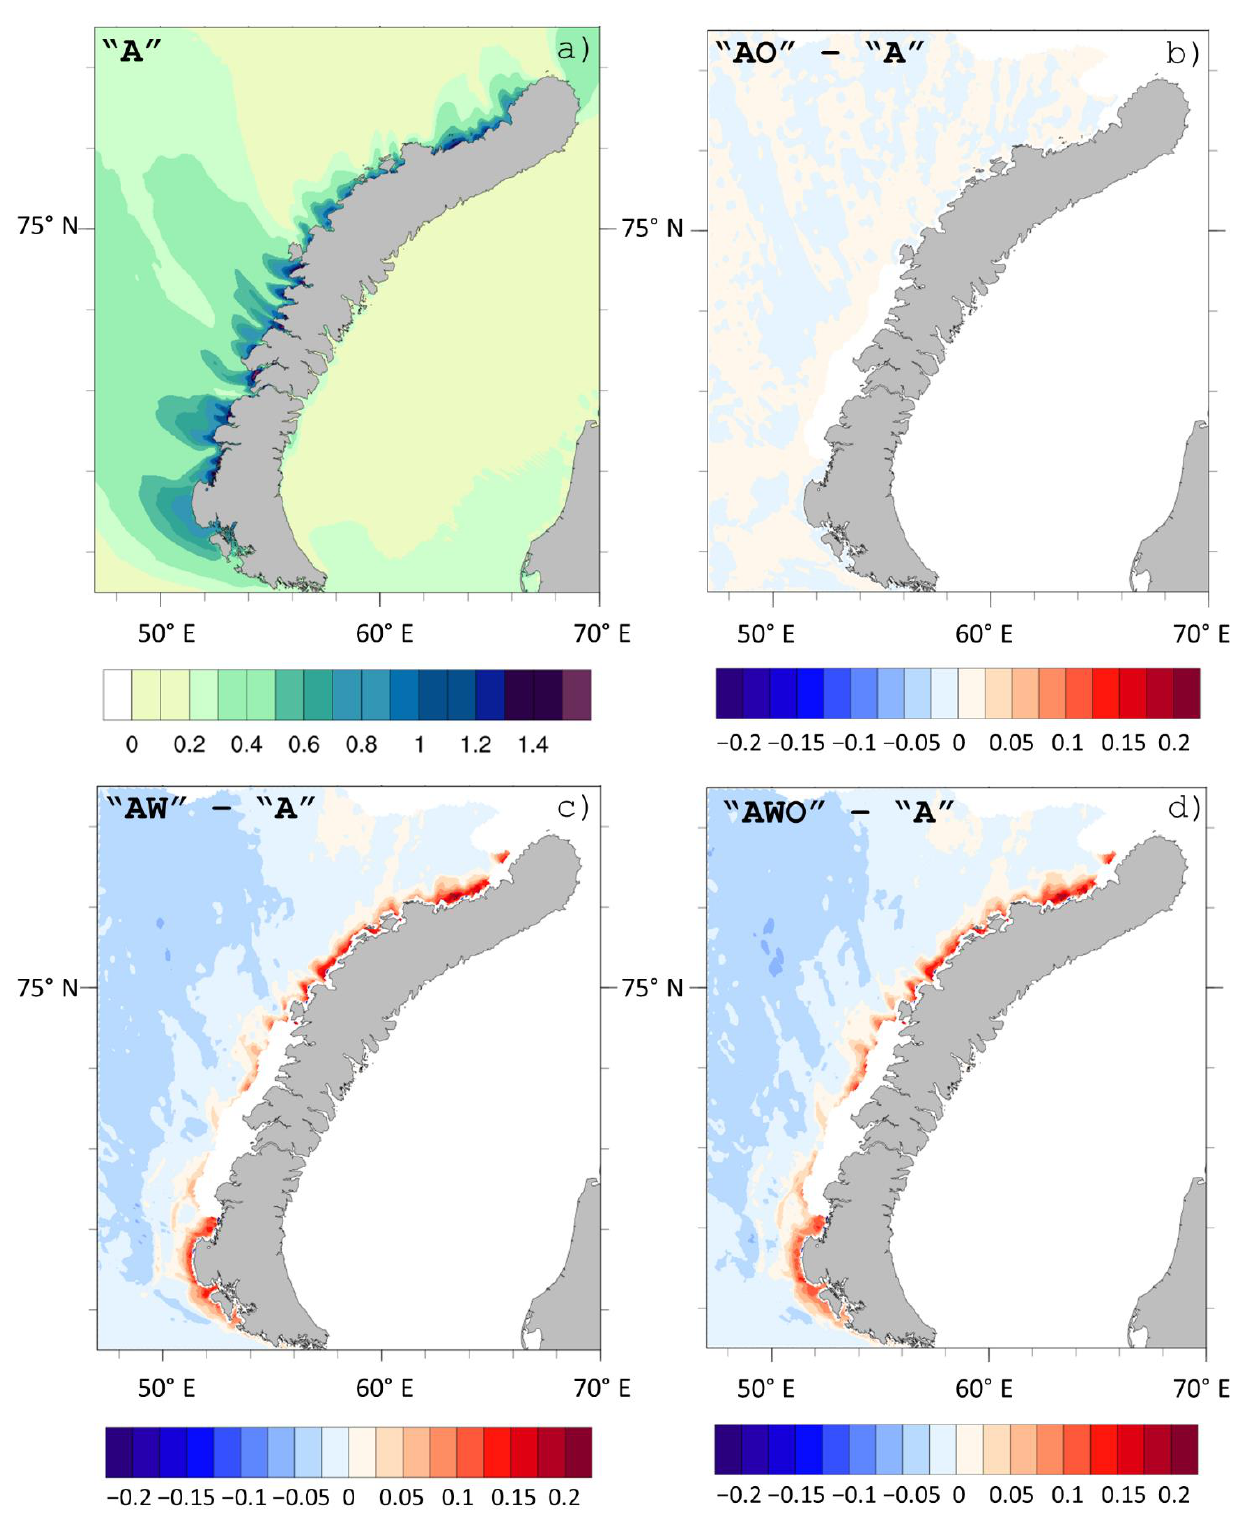
Figure 7. Momentum flux (N m − 2 ) in experiment “A” ( a ) and difference in momentum fluxes (N m − 2 ) between coupled experiments “AO” ( b ), “AW” ( c ), “AWO” ( d ) and uncoupled experiment “A” averaged over the bora period (10–12 December). Areas with sea ice from experiment “A” in ( b – d ) are shaded in white.